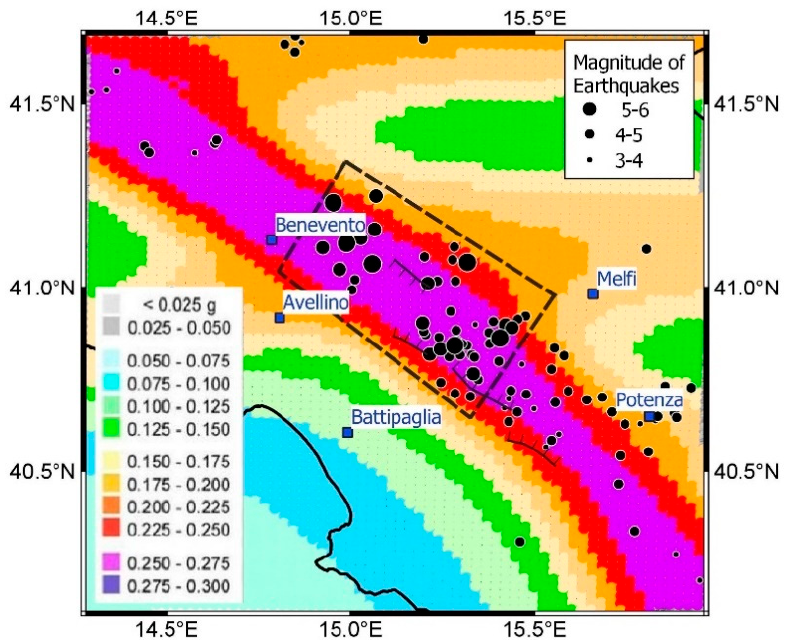
Figure 7. Map of seismic hazards in Irpinia (see [32]) and adjoining areas (colors in the background), derived mostly from the historical seismic records, as shown by the overlapping of strong seismic events within the map itself. The main towns of the area are drawn and labeled with dark blue squares, and the main faults (see Figure 2 (top)) are represented with black hashed lines. It is unlikely that in the 200-year time-span between 1732 and 1930 there were large (M 6.0+) earthquakes in the Irpinia area, since these are not present in the historical record. In the same time interval, not just “minor” earthquakes are well documented in the very same area (i.e., the 1741 Mw 5.4, 1794 Mw 5.3, and 1853 Mw 5.6 Irpinian events; see Table 1, Figure 5), but strong events are also well known to have struck other adjacent Apennine areas (the 1805 Mw 6.7 Matese earthquake; those of 1851 Mw 6.5 and 1857 Mw 7.1 in Basilicata [26]). Therefore, it can be assumed that the historical seismicity of Irpinia has been characterized by periods of intense activity, with strong earthquakes over a few years of magnitude lower than